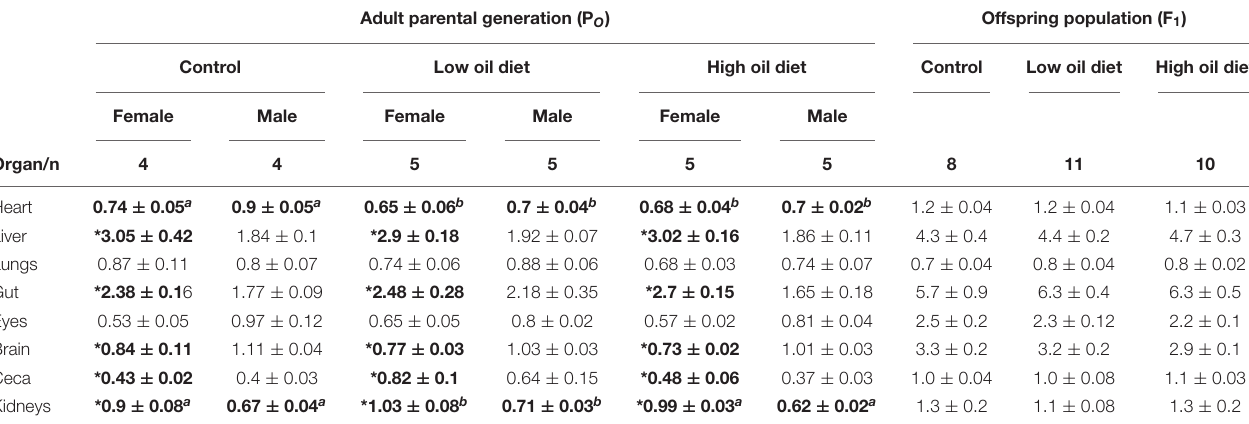
Different superscript letters indicate significant differences among experimental groups. “*” in Hct and Hb in the High oil diet group of the parental population indicates significant differences between sex. Significantly different values are also indicated in bold. TABLE 2 | Organ masses (% of body mass) in the parental adult population (P O ), and in the offspring population (F 1